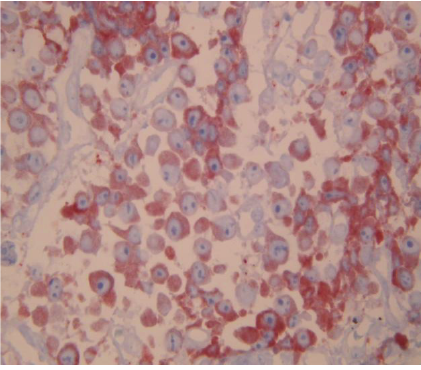
Figure 5: Skin biopsy and immunohistochemical staining reveals kappa monotypic plasma cell infiltration.